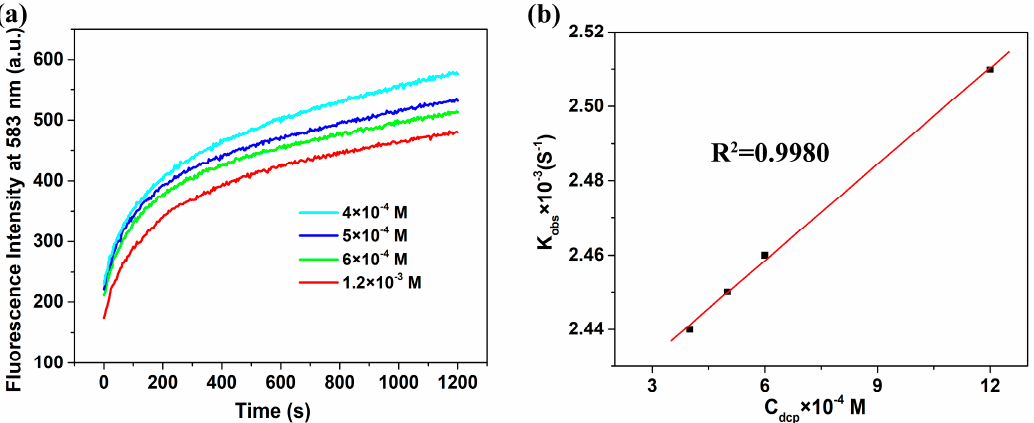
Molecules 2019 , 24 , x 4 of 12 Figure 1. ( a ) Absorption spectra of RB-CT (1.0 × 10 − 5 M) upon the addition of DCP (0.5 × 10 − 4 –8.0 × 10 − 4 M) in CH 3 CN (3% Et 3 N). ( b ) The images of the RB-CT solution before and after the addition of DCP under sun light (left) and UV light (right). ( c ) Fluorescence spectra of RB-CT (1.0 × 10 − 6 M) at λ ex = 540 nm, upon the addition of DCP (0.1 × 10 − 3 –1.9 × 10 − 3 M) in CH 3 CN (3% Et 3 N). ( d ) Plot of emission intensity of RB-CT at 583 nm. 2.2. Reaction Kinetics Study To investigate the reaction kinetics of RB-CT and DCP, time-dependent fluorescence change was performed under different DCP concentrations at room temperature. As shown in Figure 2a, the